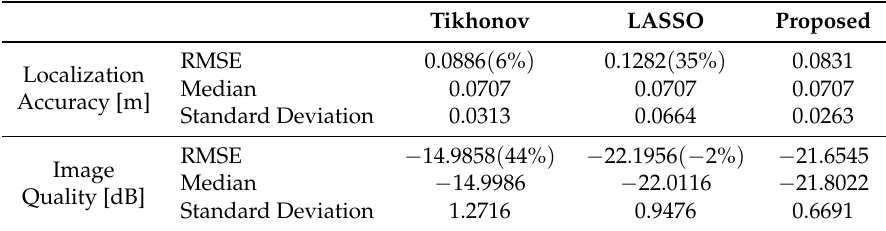
Table 2. Performance evaluation indicators of different regularization algorithms.